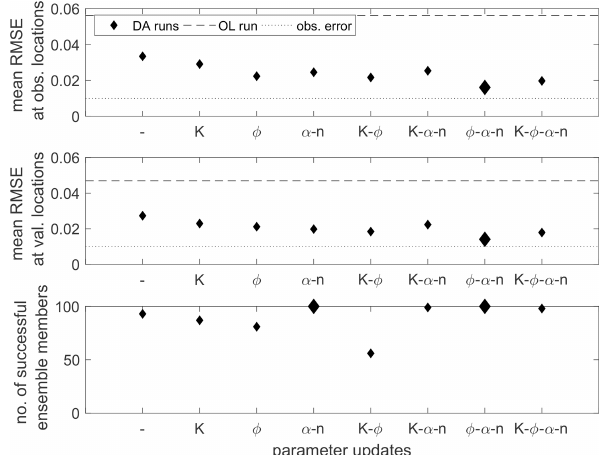
Figure 5. Spatially and temporally averaged RMSE values at the observation and validation locations for the homogeneous scenario and the different parameter update combinations. The first entry (–) denotes the data assimilation run, where only soil moisture is up- dated. The lower plot gives the number of converging ensemble members. The best values are highlighted by larger